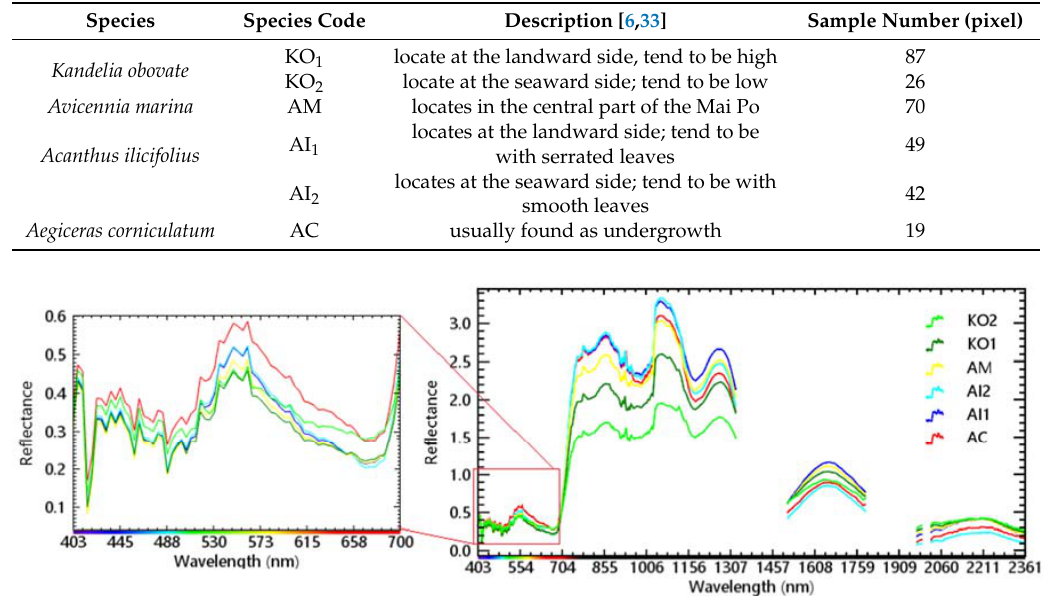
Table 4. The band number and bandwidth of five different datasets for comparison.